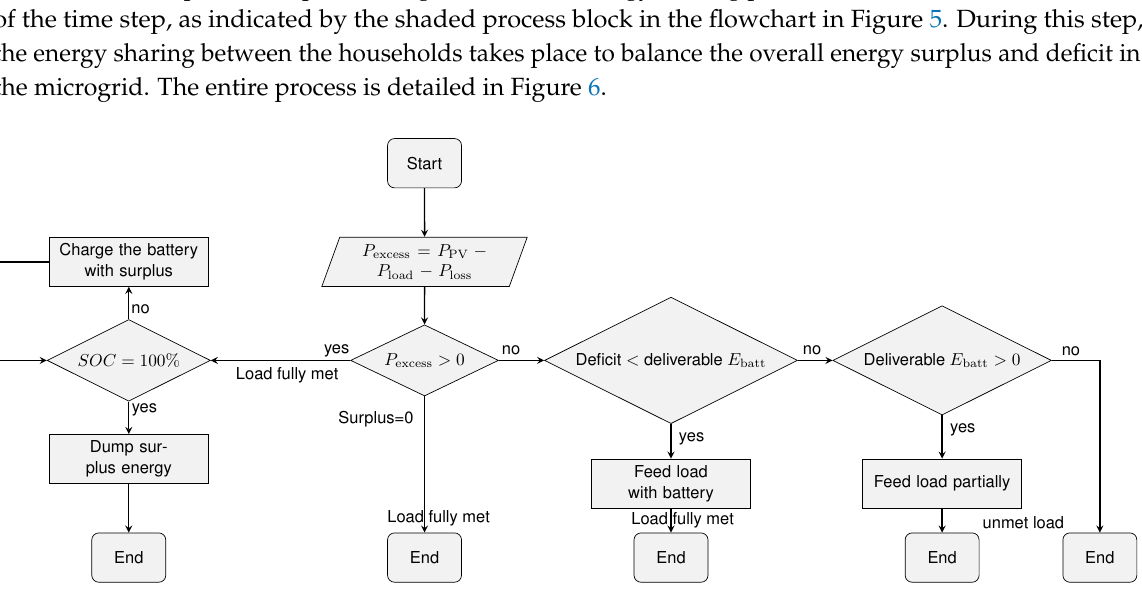
Figure 4. Flow chart explaining the power management scheme used in the standalone SHS model; it represents the algorithm followed in every time step